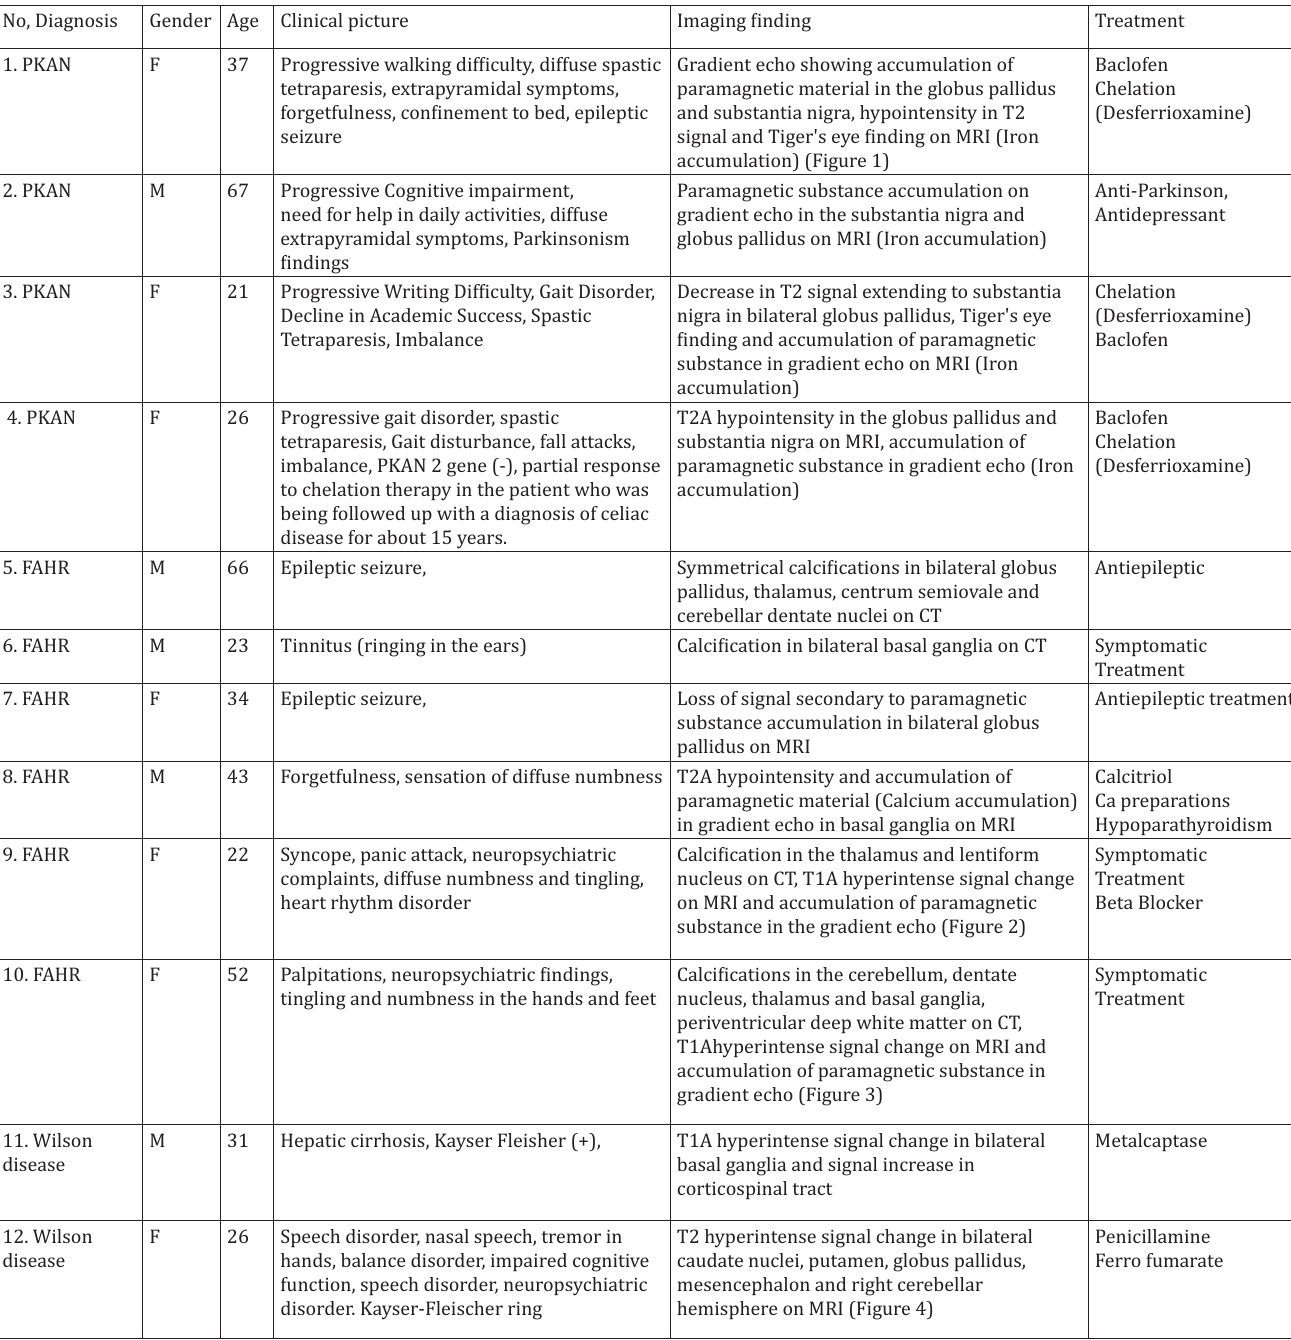
Table 1 The subjects' demographic data, clinical and imaging findings and treatment schedules No, Diagnosis Gender Age Clinical picture Imaging